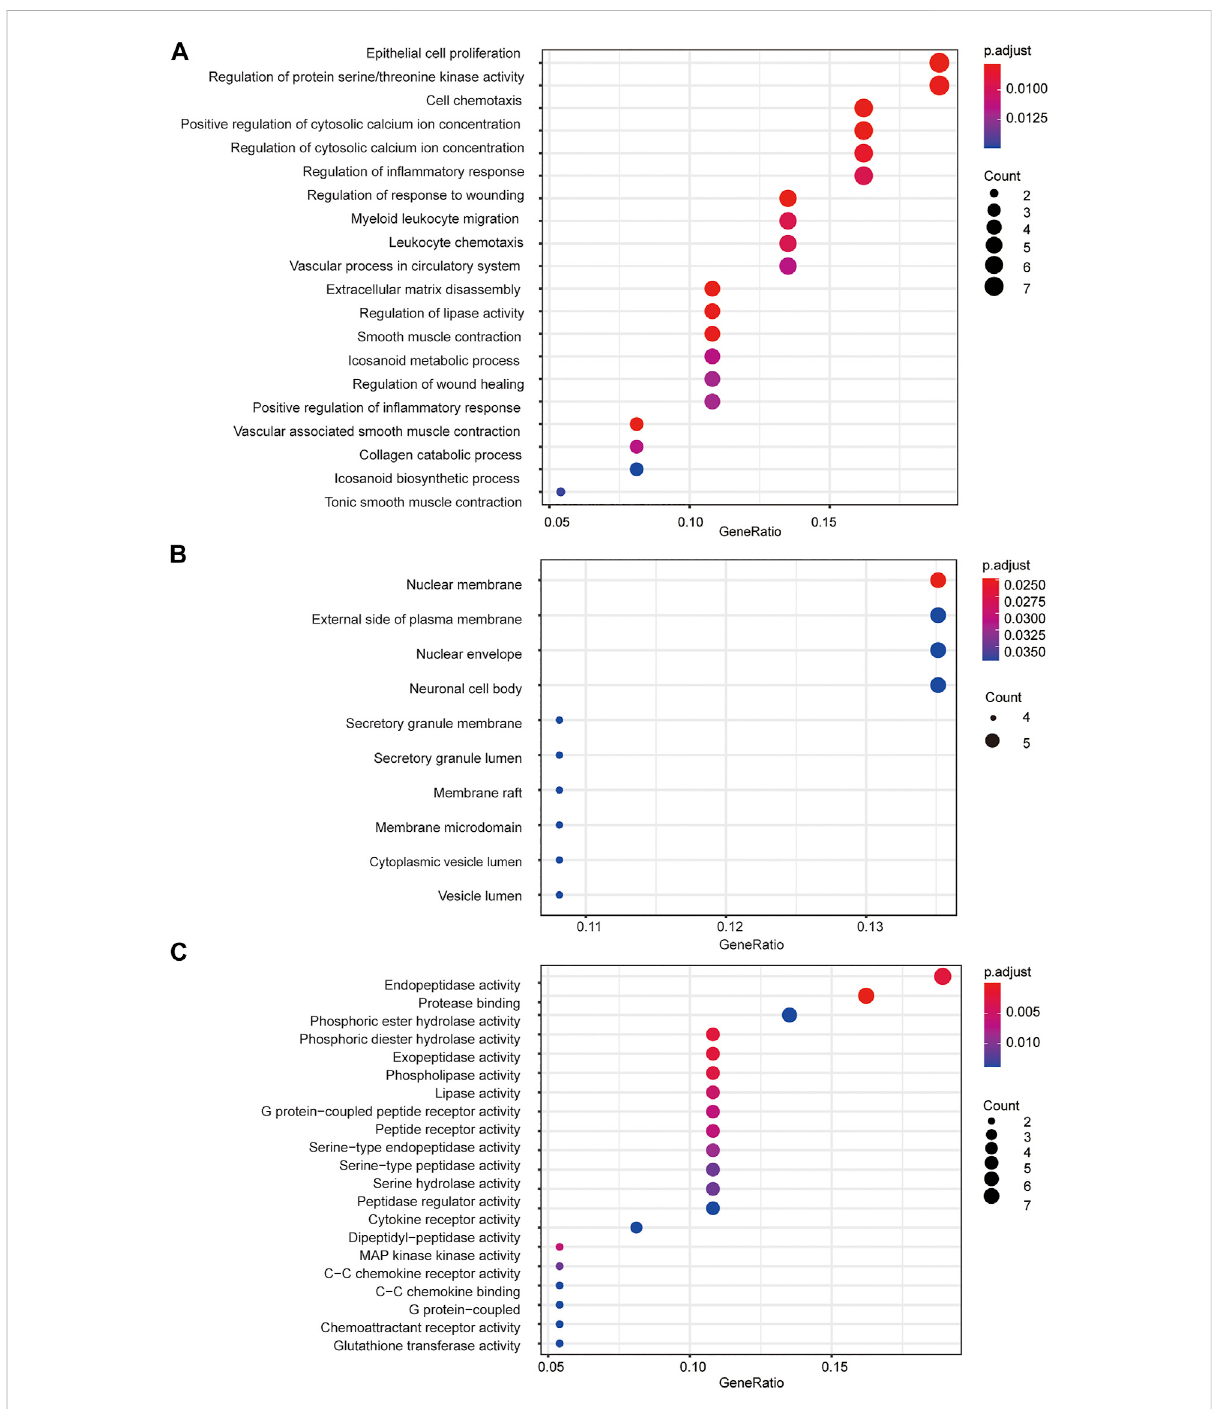
FIGURE 3 GO functional analysis. (A) GO biological processes of37 core genes. (B) GO cellular component of37coregenes. (C) GO molecularfunction f 37 core